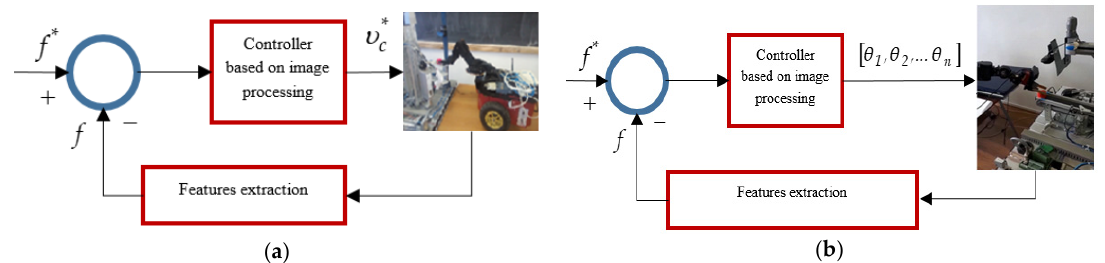
Figure 10. Eye to hand VSSs based closed-loop control: ( a ) of ARS Pioneer 3-DX equipped with RM Pioneer 5-DOF for picking up the work-piece with VSS1; ( b ) of RM Cyton for releasing the work-piece with VSS2, [9]. @2019 IEEE.